Question: Summarize what this figure shows in one sentence.
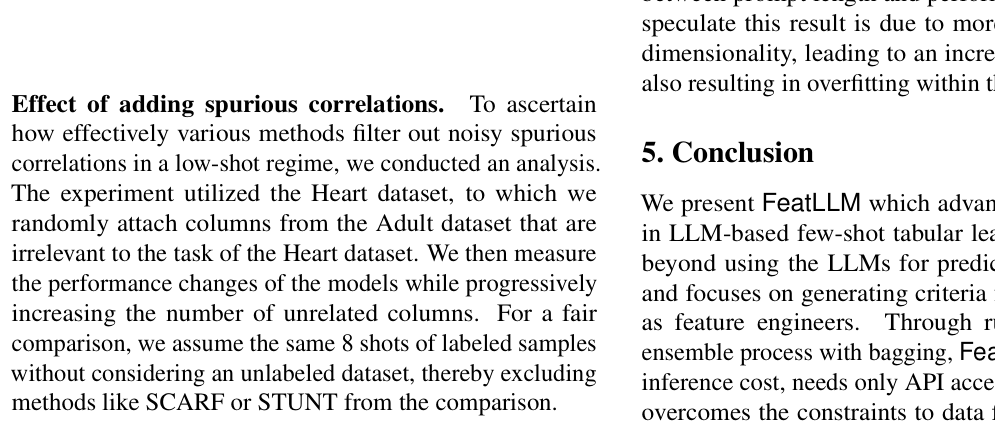
Answer: Visualization of performance impact from spurious correlations. The results exhibit the models’ performance (AUC) each time a noisy column from the Adult dataset is added to the original Heart dataset. XGBoost is excluded here due to its lower performance.